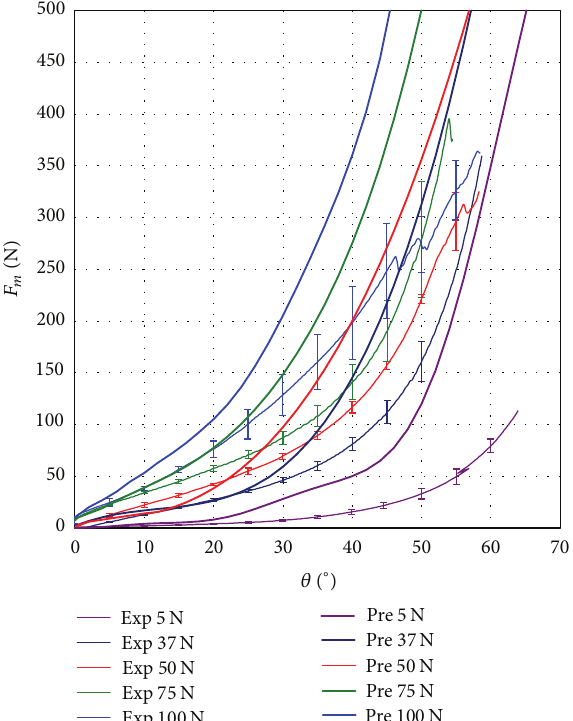
Figure 5: Comparison between the experimental [10] and the predicted results using non-normalized 𝐹 𝑠 −𝜃 of BBE in the coupling